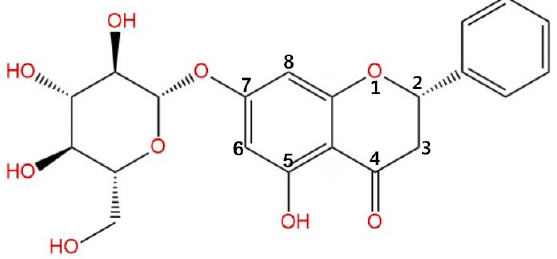
Figure 1. Chemical structure of pinocembrin-7-glucoside (P7G).